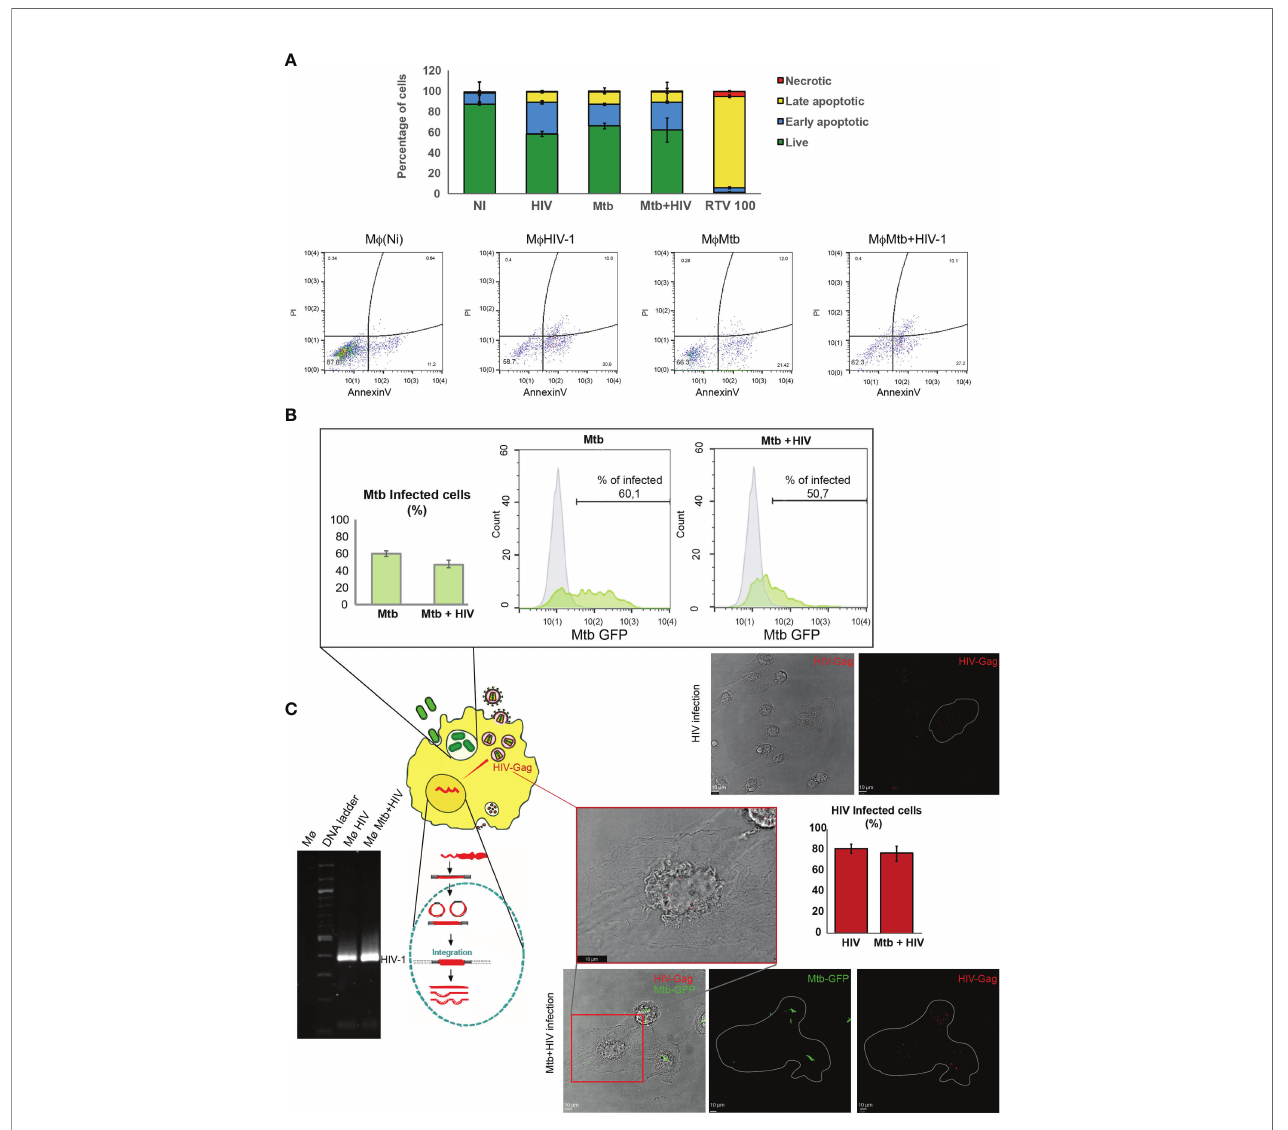
FIGURE 1 | Infection with either Mtb or HIV, or coinfection with pathogens, in human Mø does not impact cell death. (A) Flow cytometry analysis of the percentage of infected cells stained for annexin V and/or with propidium iodide 48 h p.i. Results represent the mean of biological triplicates for each challenge. (B) Percentage of Mtb-infected Mø during mono-infection or during coinfection with HIV after 3 h p.i. determined by fl ow cytometry. Bar plot depicts the mean ± SEM of three independent experiments. (C) HIV infection of Mø during mono- or coinfection with Mtb. Images represent z-axis maximum intensity projections of Gag/p24 protein depicted in red and Mtb depicted in green on a single plane of the bright- fi eld channel, visualized by confocal microscopy. Bar plots represent the mean percentage of cells infected by HIV obtained from the microscopic analysis of 250 cells per treatment in ImageJ software. Error bars show the standard deviation. Gel electrophoresis shows the result of nested PCR ampli fi cation of HIV-1 (92US660) LTR with 391 base pairs (bp). Mtb, Mycobacterium tuberculosis ; Mø, macrophages; p.i., post infection; LTR, long terminal